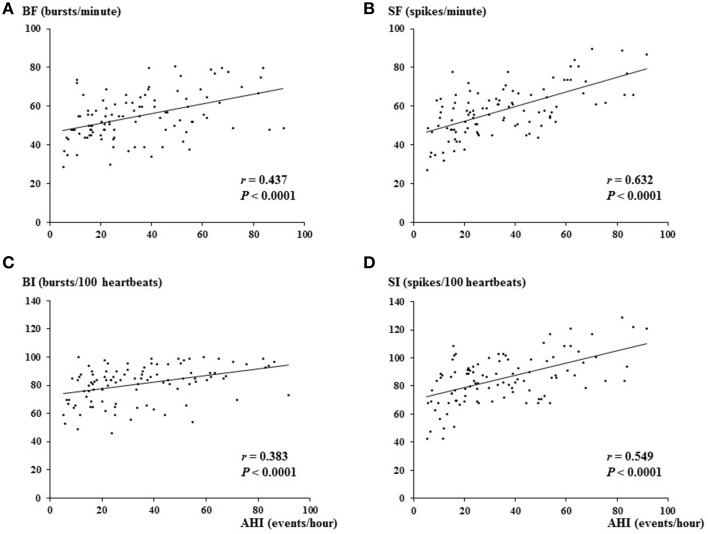
Relationship between AHI and multi-unit MSNA (A, burst frequency; C, burst incidence) or single-unit MSNA (B, spike frequency; D, spike incidence). The correlation coefficient between single-unit MSNA and AHI was stronger than that between multi-unit MSNA and AHI. AHI, apnea-hypopnea index; BF, burst frequency; SF, spike frequency; BI, burst incidence; SI, spike incidence.